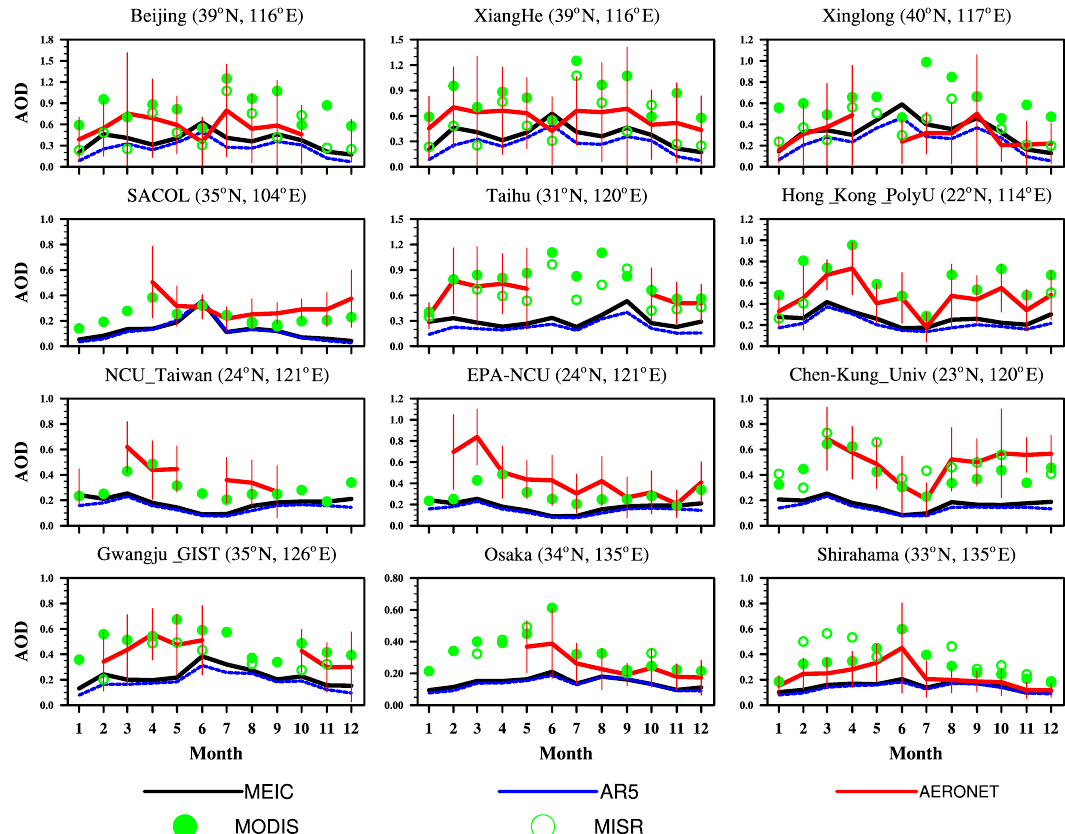
Figure 5. Monthly-average AOD simulated by CAM5-MAM3 using the MEIC emission and the AR5 emission compared with the AERONET, MODIS, and MISR observations at 12 AERONET sites in and around China. The error bars represent 1 standard deviation of the daily AERONET observations within the